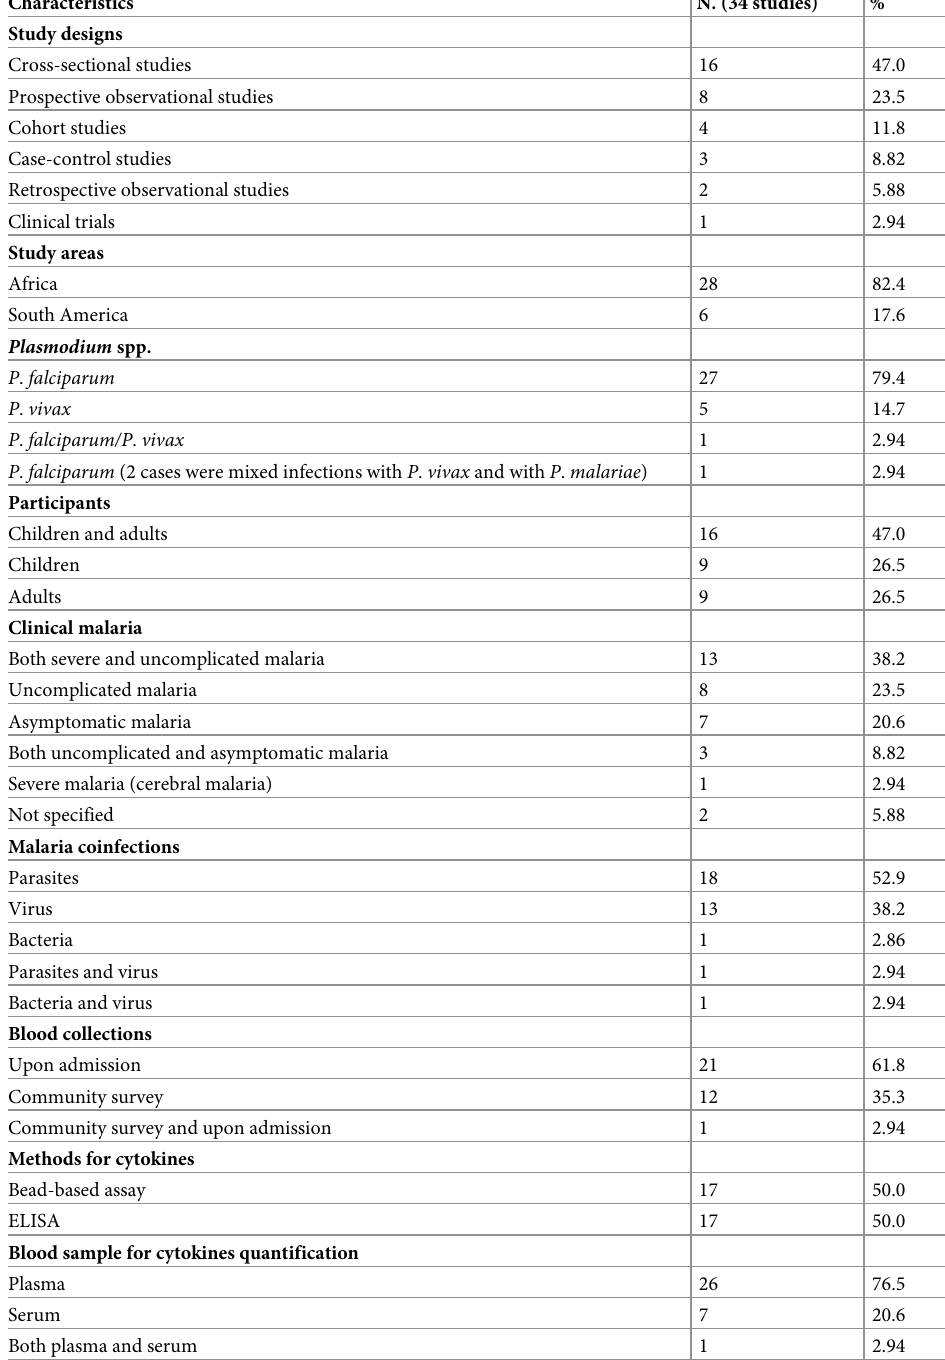
Table 1. Characteristics of the 34 studies included in the